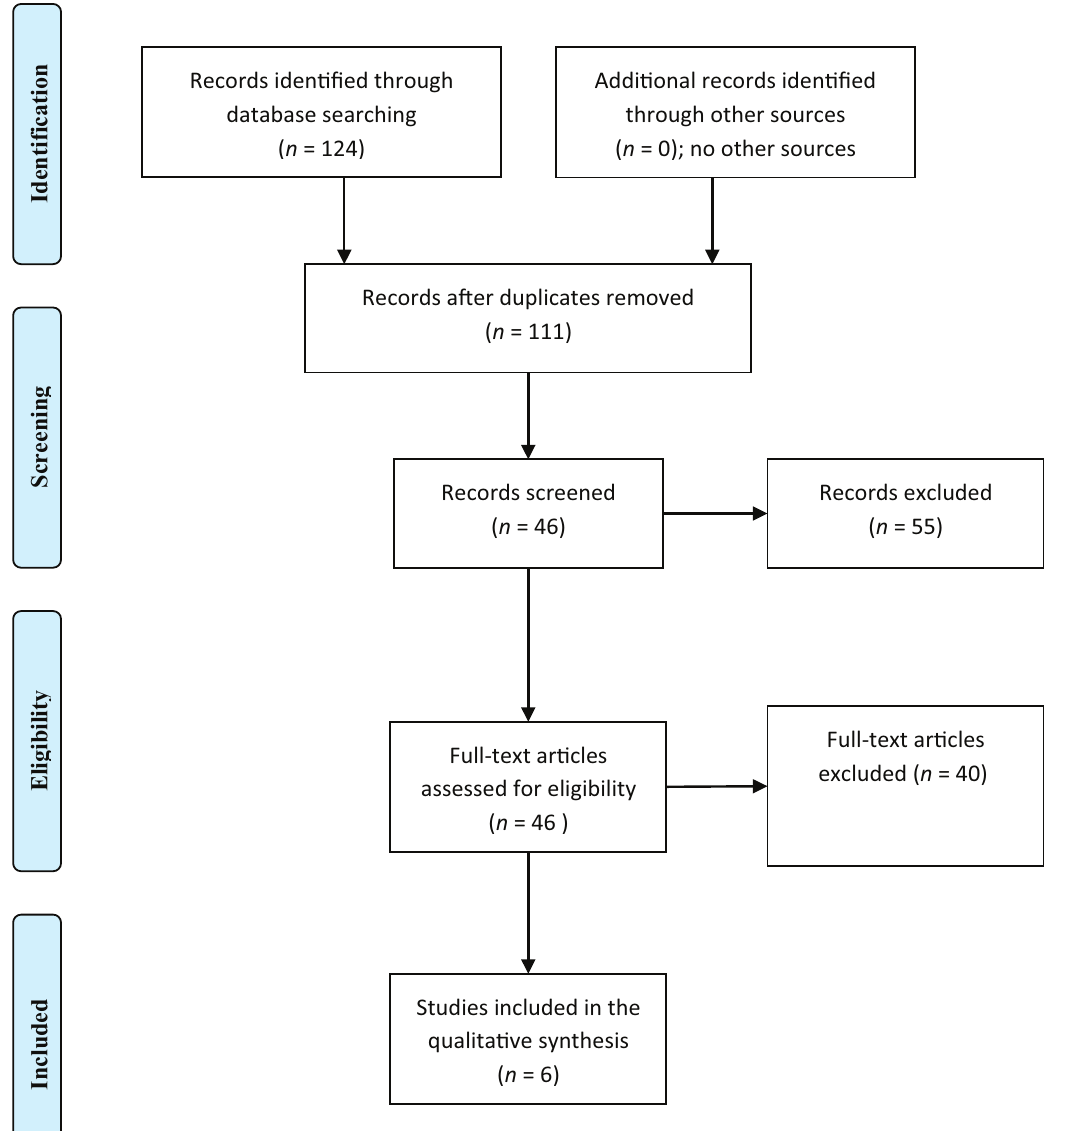
Figure 1: Flow diagram of the different phases of the systematic review (PRISMA